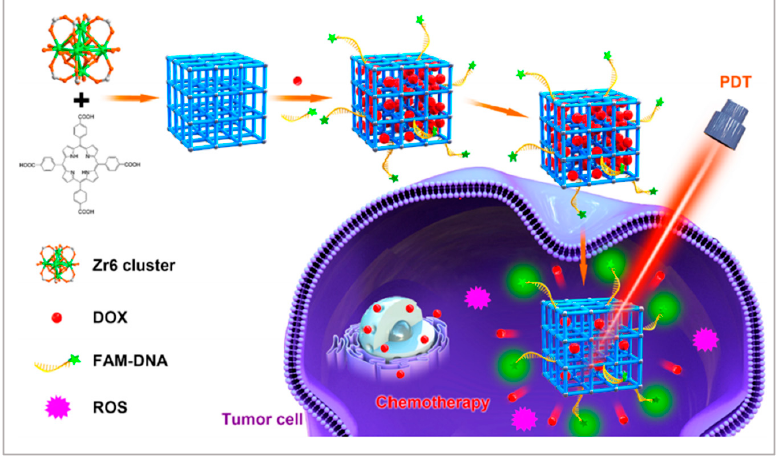
Figure 7. Schematic representation of DNA-functionalized NMOFs for targeted drug delivery and PDT. Reprinted with permission from [109]. Copyright © 2019 American Chemical